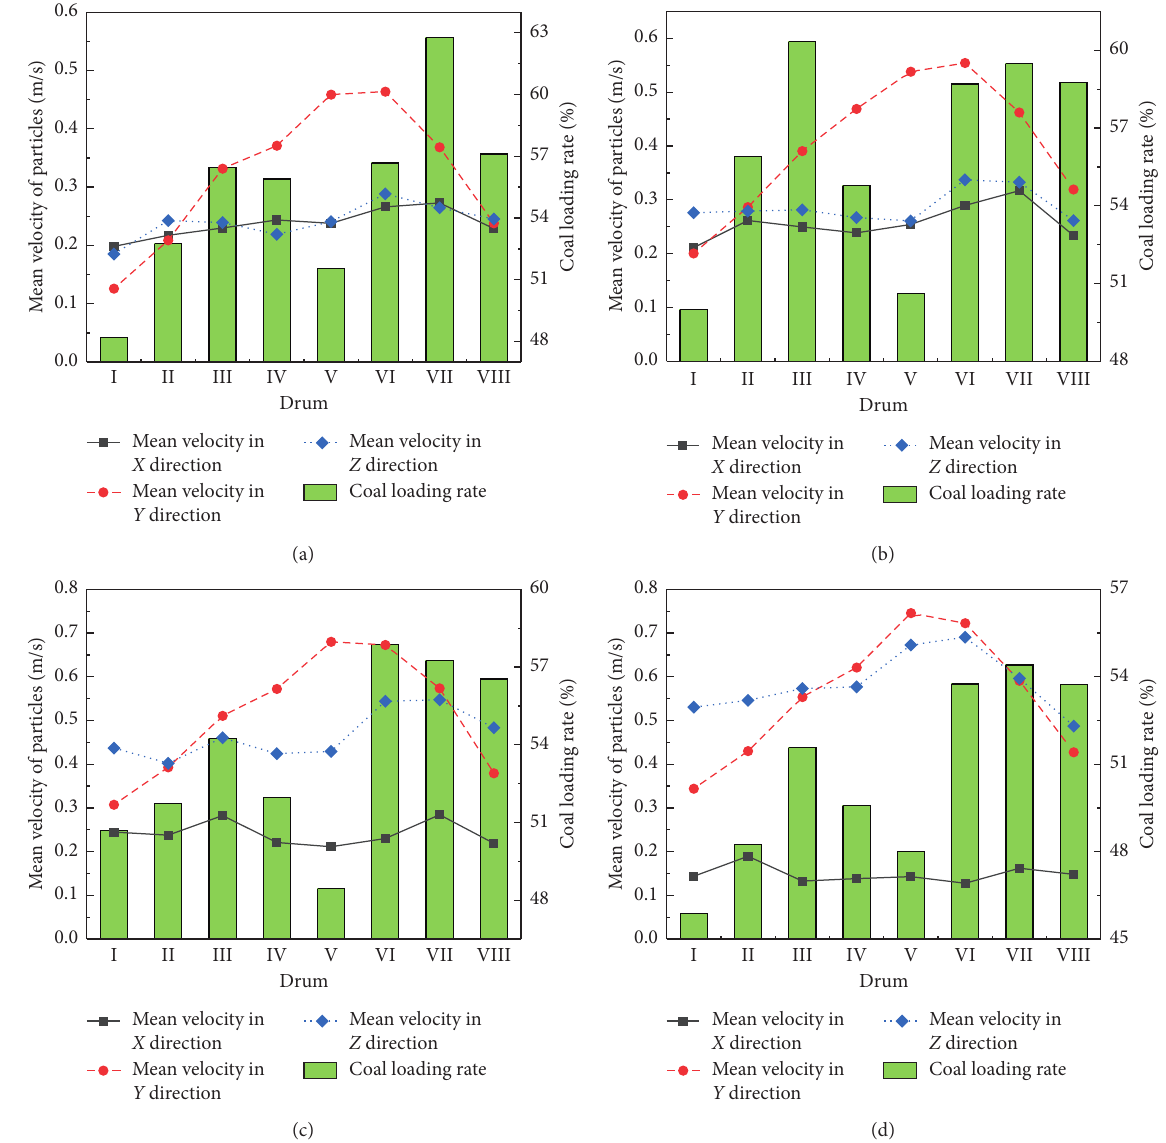
Figure 8: The relationship between particle velocity in three directions and loading rate at different rotational speeds: (a) 40rpm, (b) 60rpm, (c) 80rpm, and (d)